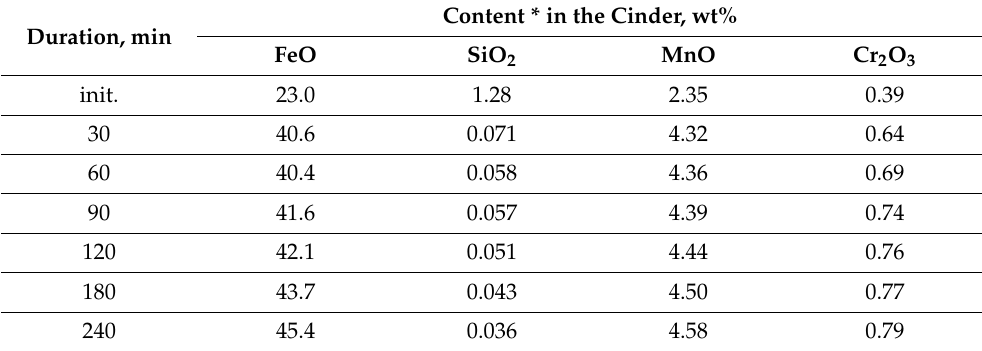
Table 5. Effect of the duration of the experiment on the content of impurity components in the cin ‐ der. Duration, min